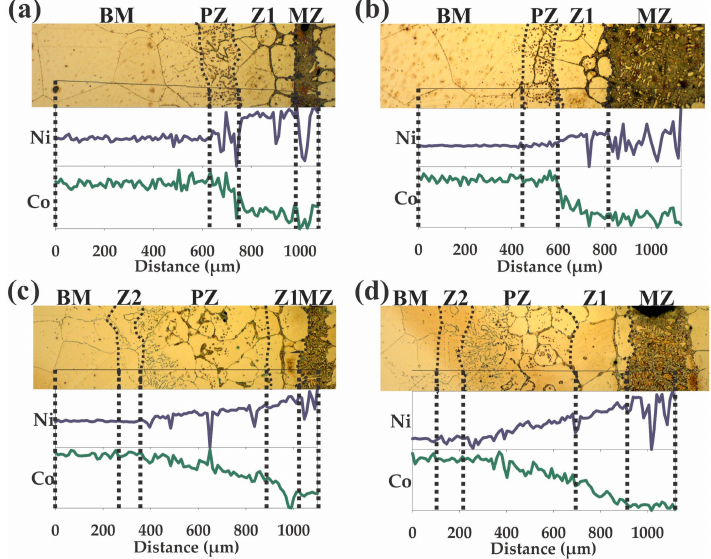
Figure 15. Linear profile by EDS of Ni and Co in di ff erent sections of wedge-samples: ( a ) Sol-Wasp narrowsection, ( b )Sol-Waspwidesection, ( c )Ni-Sol-Waspnarrowsection, ( d